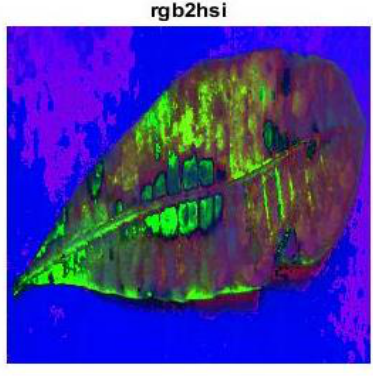
Figure 5. RGB to HSI of the input image The RGB image is converted into the HSI image as shown in figure 5. HSI image is used in segmenting the portion of the image.